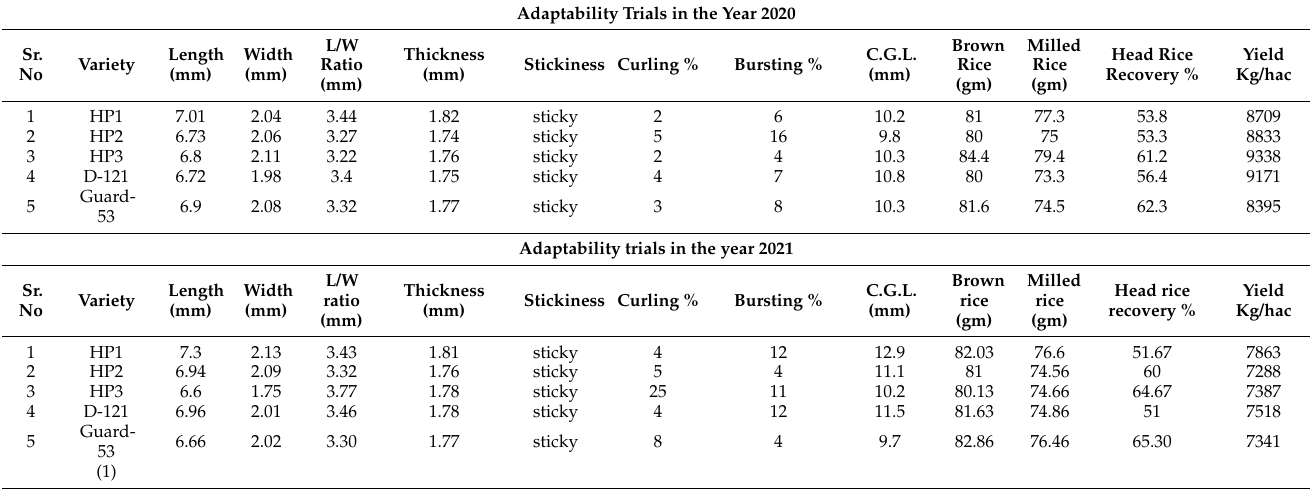
Table 3. Yield and quality traits comparison of hybrids with check varieties in adaptability